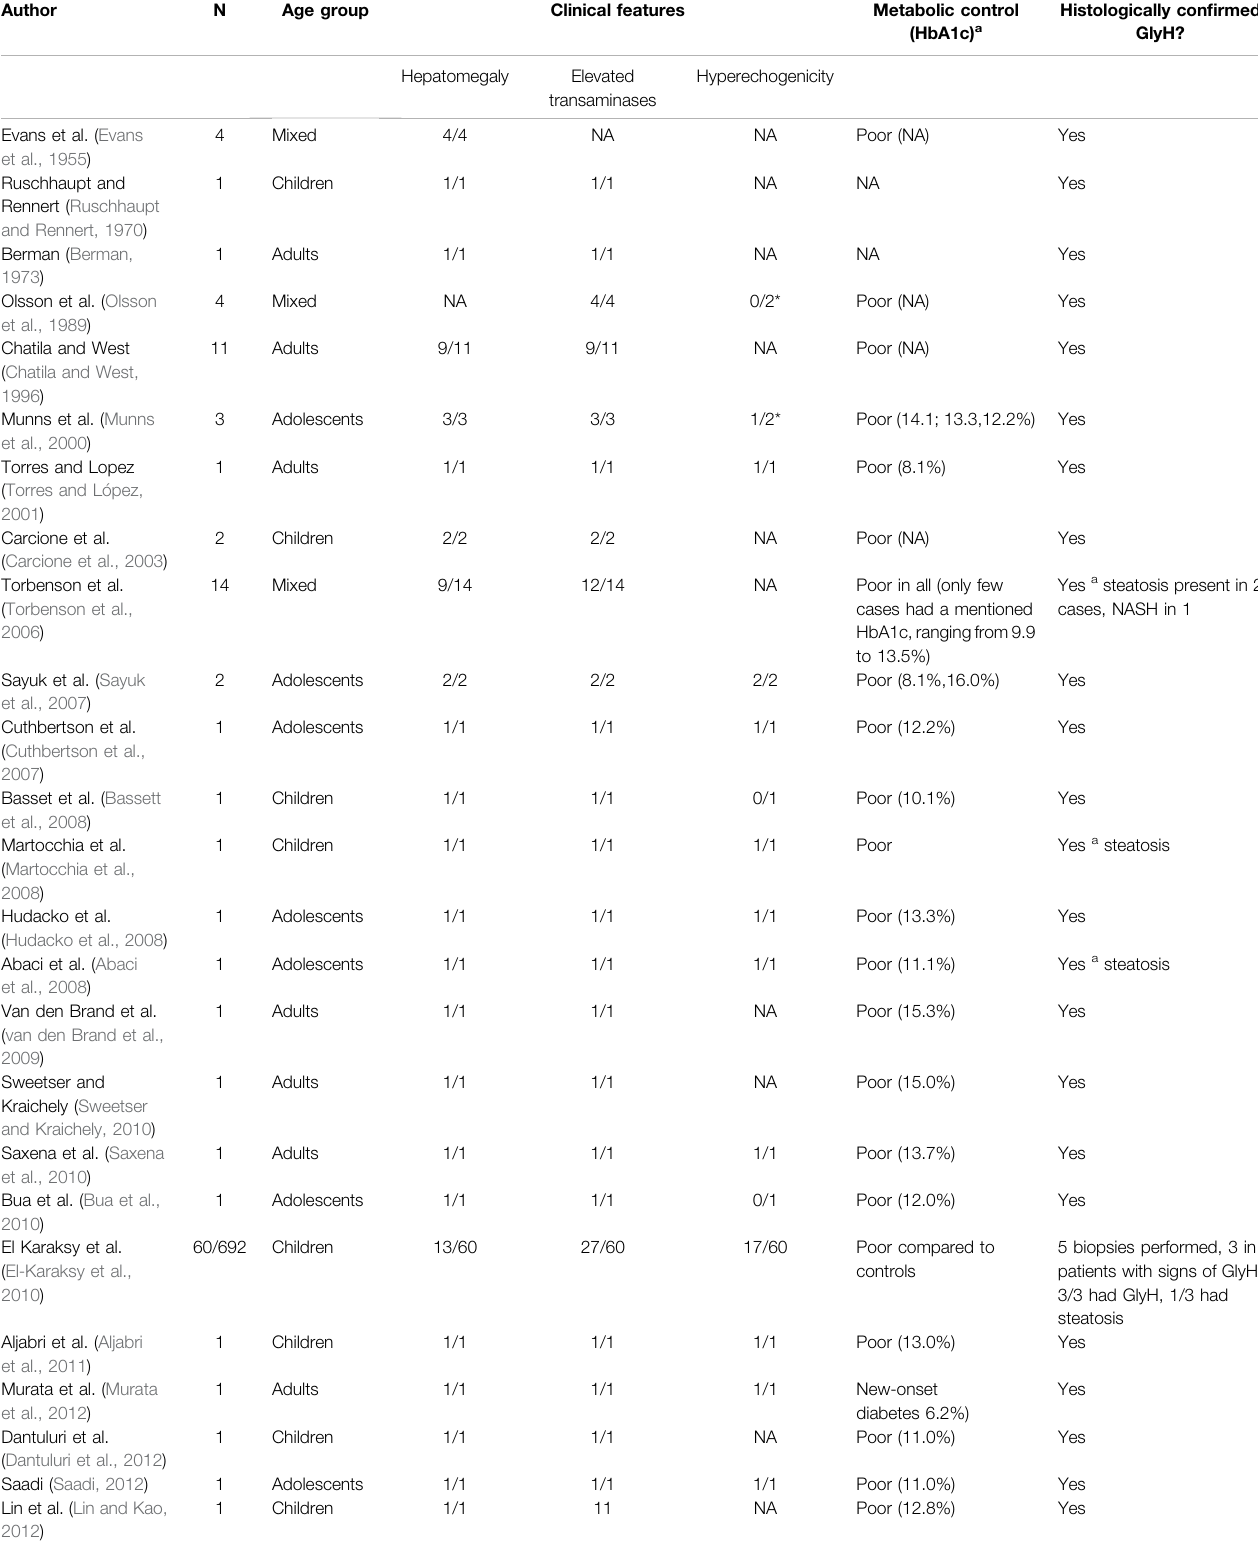
TABLE 1 | Summary of published cases of GlyH in